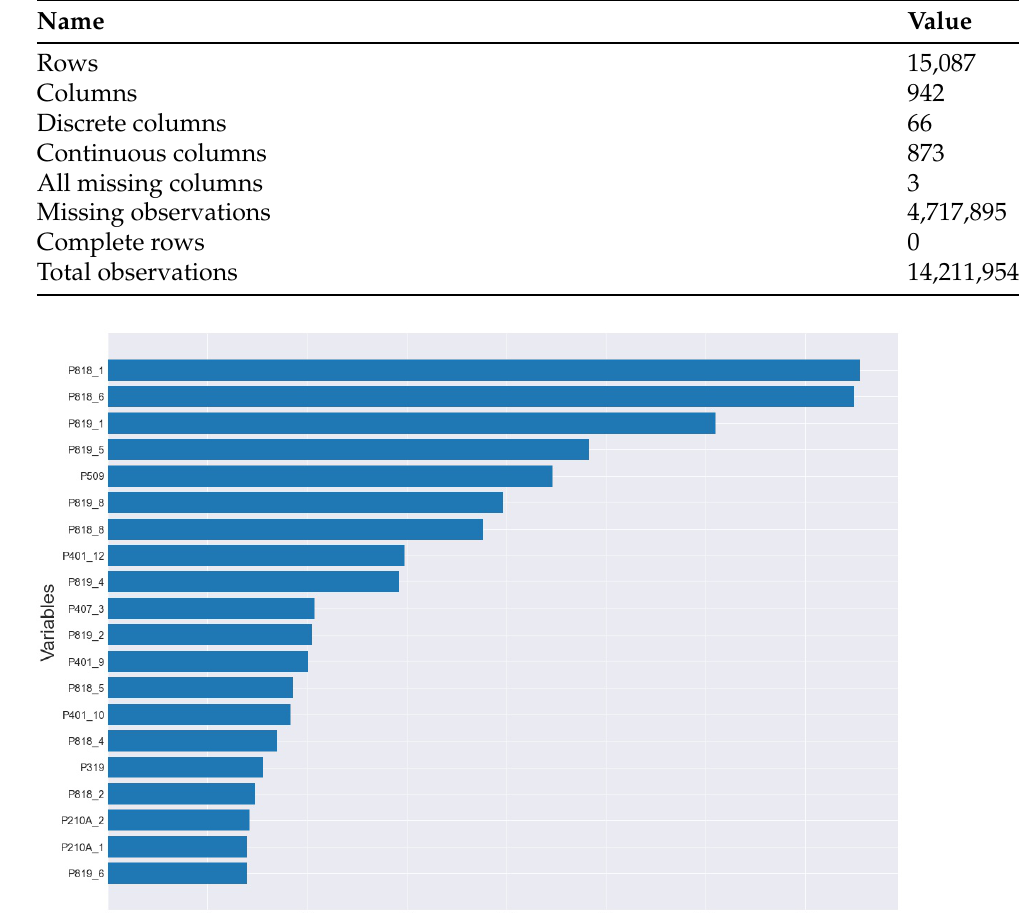
Table 1. Overall summary of ENDO-2018 data set.